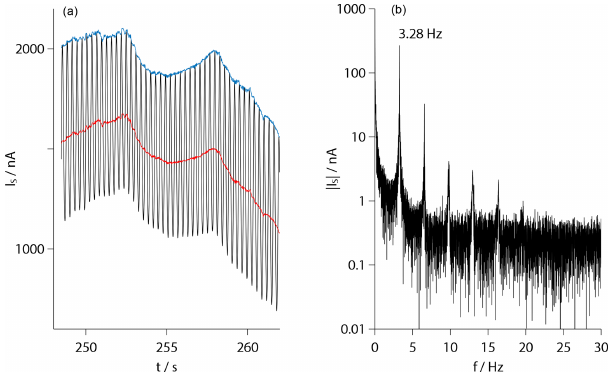
Figure 10. (a) Detail of the transient sensor signal showing peri- odical oscillations due to the payload rotation. The red curve is the result of a filtering by several narrow-bandwidth notch filters, and the blue curve is obtained by subsequent fitting to the maximums. (b) Frequency spectrum of the raw signal with clear peaks at the rotational frequency and its